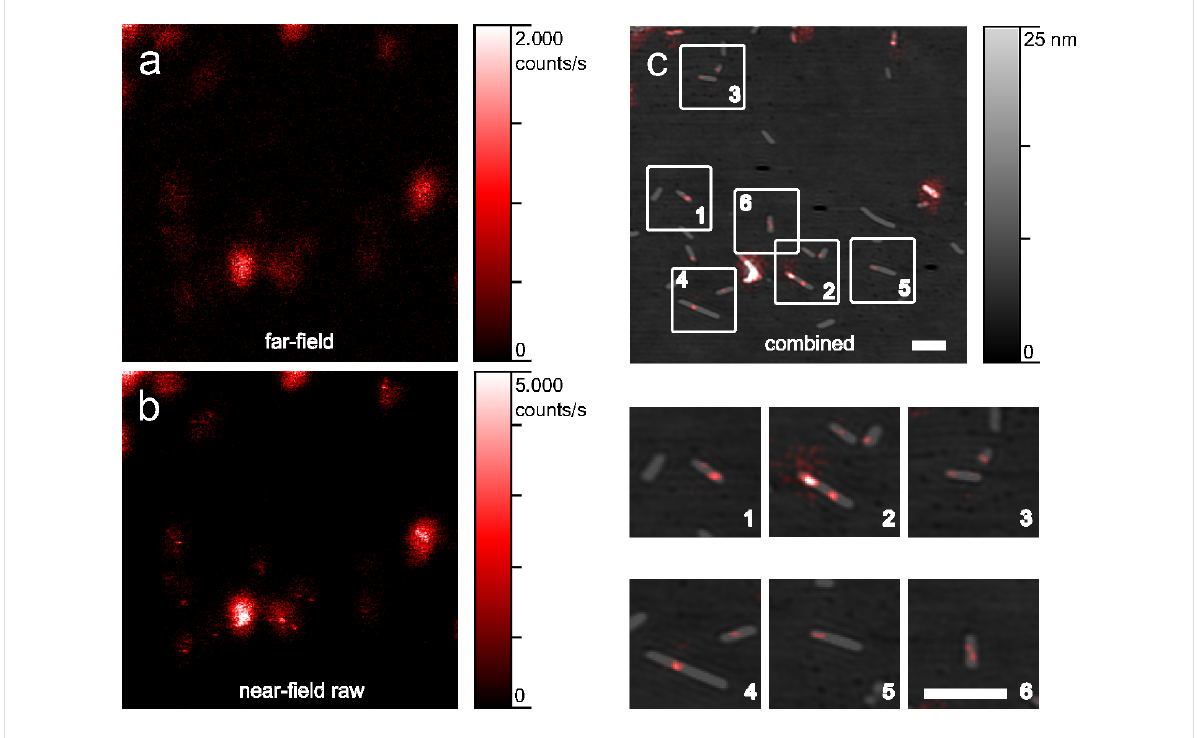
Figure 3: aSNOM dataset of TMV (a–c, 5×5 µm 2 ). a) Blurry far-field fluorescence acquired at the upper reversal point of the oscillating cantilever. b) The raw near-field fluorescence was recorded at the lower reversal point of the cantilever. The near-field contribution is located at the center of the dim stray fluorescence. c) The plain near-field fluorescence data is superimposed on the AFM topography. The marked areas are magnified for better visibility. All scale bars indicate 500